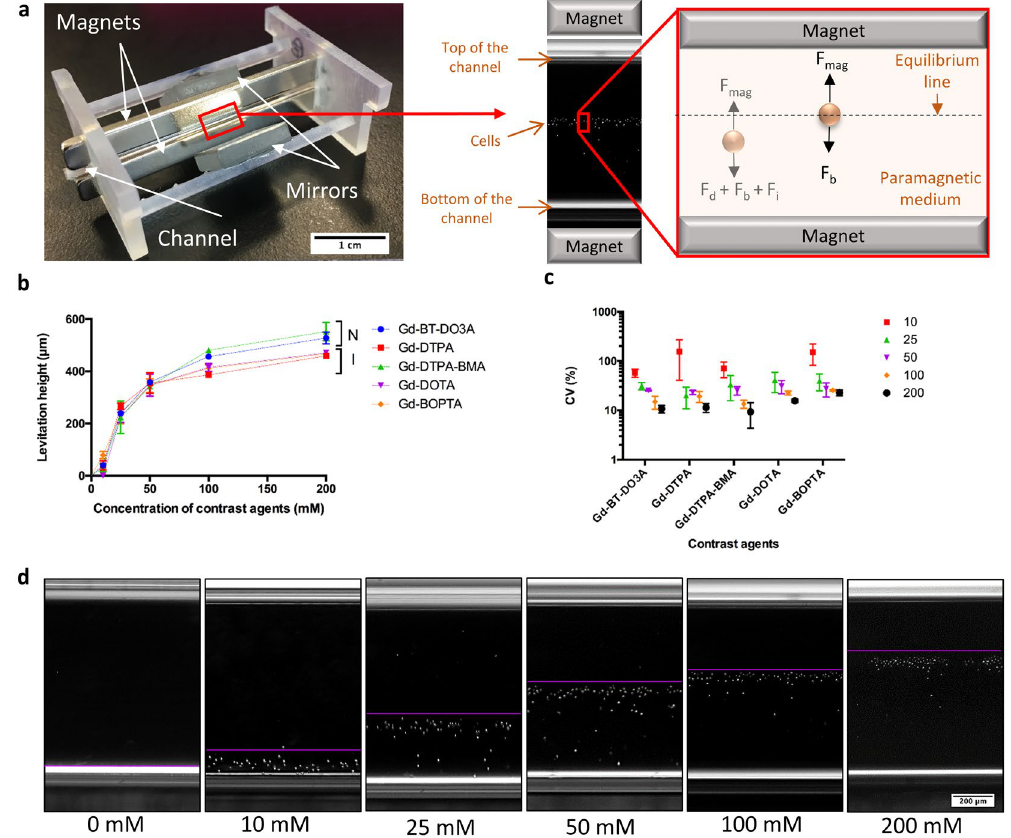
Figure 1. Short-term levitation of D1 ORL UVA cells in the magnetic levitation platform. ( a ) Photograph of magnetic levitation platform and forces which act on cells in it until equilibrium; fluidic drag force (F d ), inertial force (F i ), buoyancy force (F b ) and magnetic force, F mag , and at the equilibrium position; F mag and F b . Microcapillary channel, in which cells are levitated and cultured, is placed between two permanent neodymium magnets whose same negative poles are facing each other. Mirrors are placed at each open side of the channel at 45° and used to visualize cells in the channel with conventional microscopy systems. ( b , c ) The relationship between Gd concentrations and, levitation heights of cells (from bottom surface of capillary) ( b ) and CV (%) of levitation heights ( c ) after 10 min of levitation in different Gd-based solutions (Gd-BT-DO3A, Gd-DTPA, Gd-DTPA-BMA, Gd-DOTA and Gd-BOPTA). Data are plotted as mean of replicates with error bars ( ± SD). N: nonionic agents, I: ionic agents. ( d ) Micrographs of levitated cells after 10 min of levitation in the medium containing Gd-BT-DO3A at variable concentrations (0, 10, 25, 50, 100 and 200 mM). The lines show the upper level of the levitated cell population. Scale bar: 200 μ